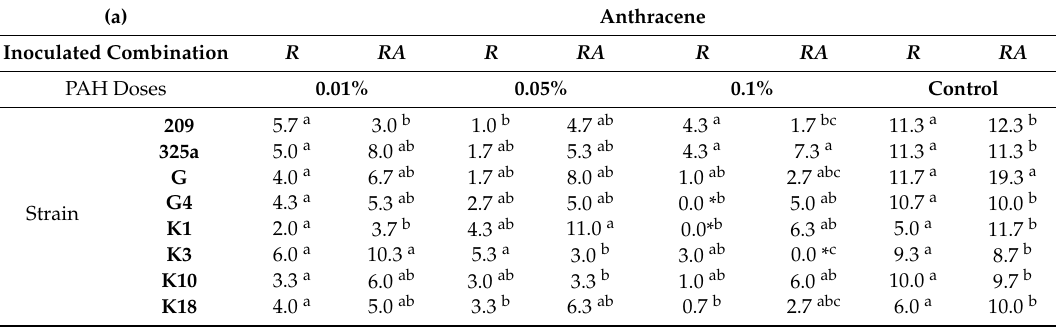
Table 4. Average ( n = 3 ) number of root nodules on clover depending on the dose of contamination with each PAH: ( a ) anthracene and ( b ) pyrene. The inoculated combination is given by R (inoculated with R. leguminosarum only) or RA (co-inoculated with R. leguminosarum and A. brasilense strains). Control samples were grown without PAH. The di ff erent letters (a–c) in the columns indicate significant results (Fisher’s LSD test, P ≤ 0.05, n = 3). * means that in this combination the average number of root nodules on the plants ( n = 3) was